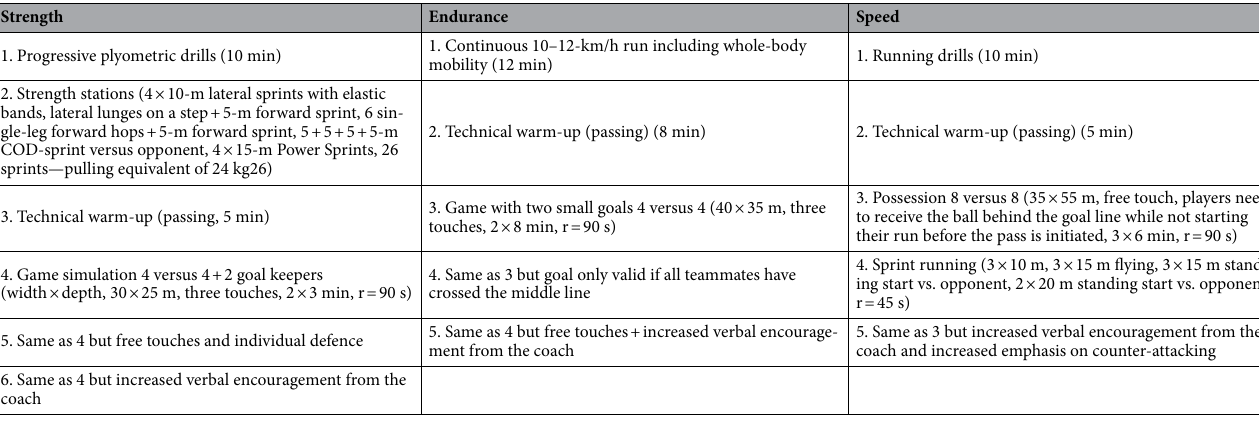
Table 1. Football training